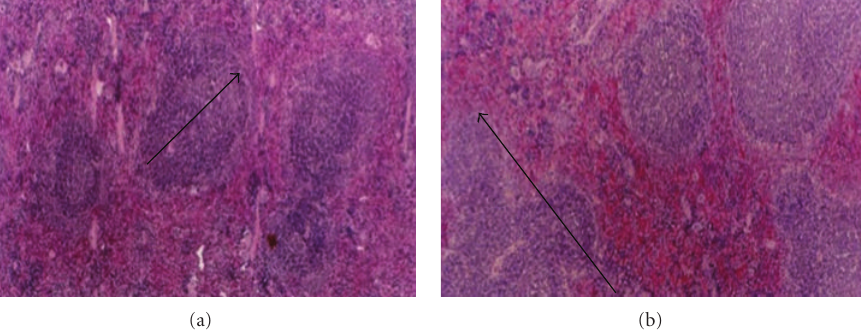
Figure 6: Enlargement of spleen lymphoid nodules due to V 2 O 5 exposure. (a) Normal histology of spleen in control animals. (b) The growth of the white pulp mainly by lymphoid nodules (arrows) in the spleen from V 2 O 5 that exposed animals is observed.